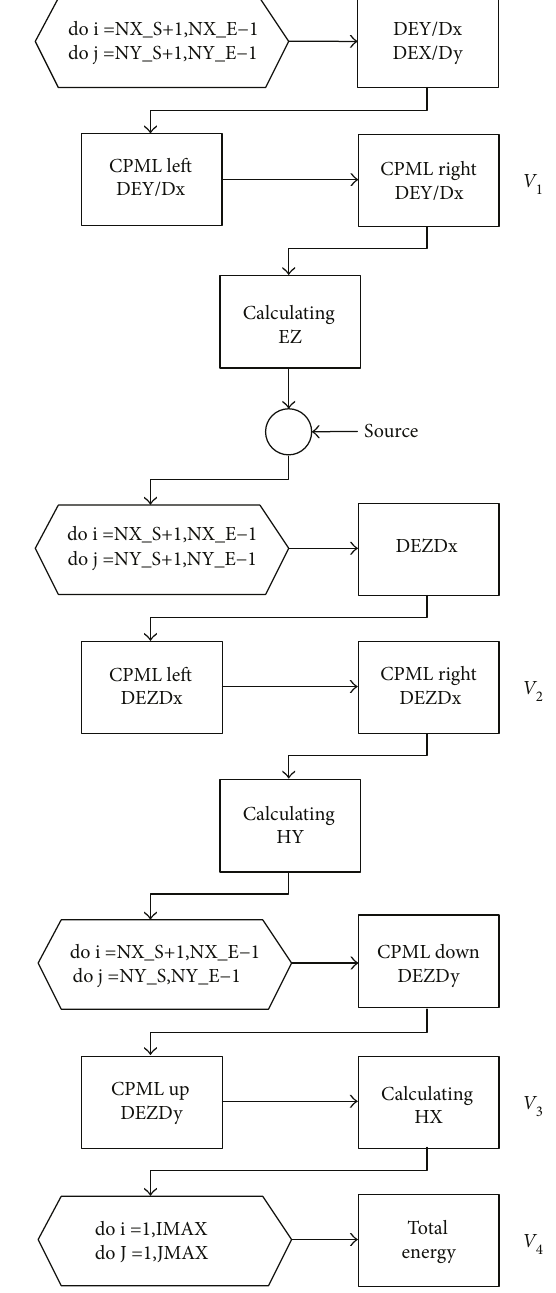
Figure 3: Flux diagram of the numerical algorithm using memory variables in all the domain. The number of used cycles is numbered as V 1 , V 2 , V 3 , and V 4